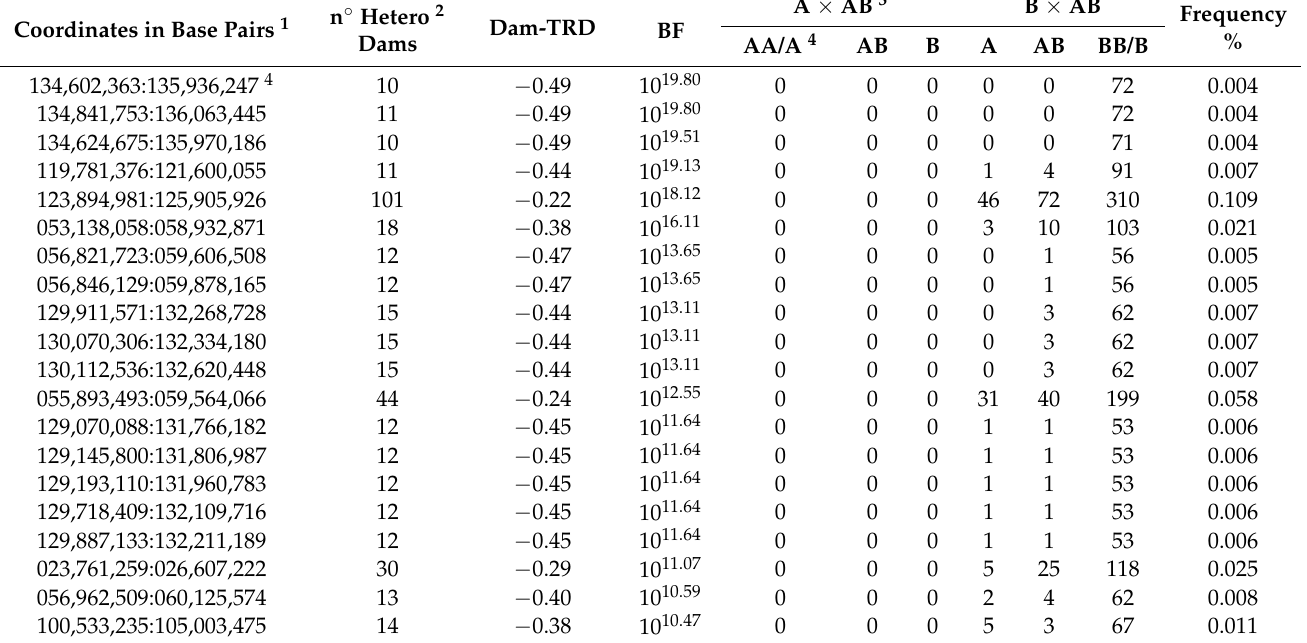
Table 3. Significant dam-TRD among heterosomal part in Holstein X-chromosome for haplotype analyses. n ◦ Hetero Coordinates in Base Pairs 1